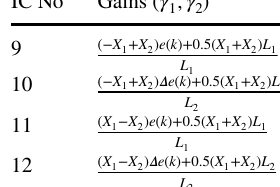
Table 3 Expressions of gains